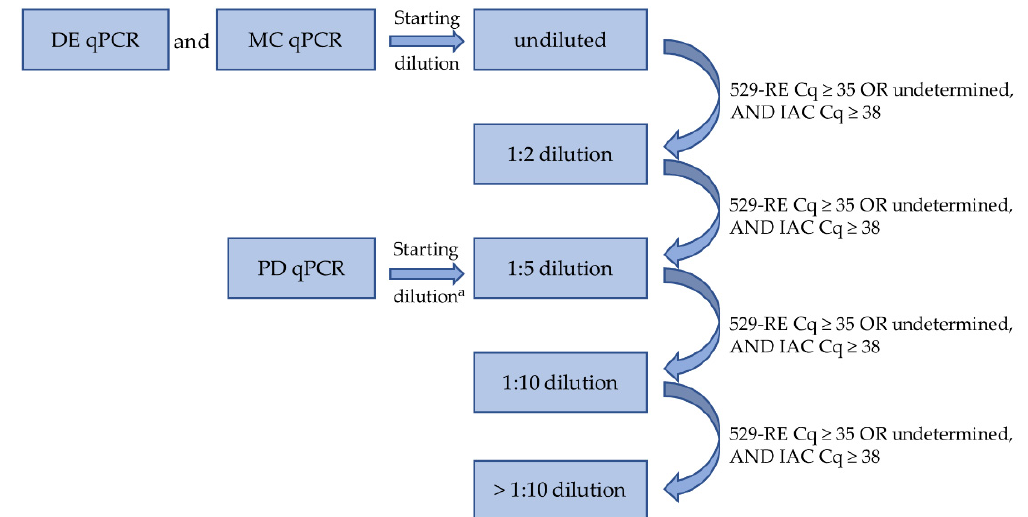
Figure 1. Methodology scheme for molecular detection of Toxoplasma gondii , showing different dilution levels used in qPCR. We used 10 µ L of template DNA for the detection of T. gondii DNA via 529-bp repetitive element (RE) qPCR. DNA from direct DNA extraction (DE) from 5 g of muscle tissue was analysed via 529-RE qPCR (DE qPCR). DNA of 50 g of muscle tissue was examined by 529-RE qPCR after magnetic capture (MC qPCR). Another 50 g of muscle tissue was investigated via 529-RE qPCR after pepsin digestion (PD) and DNA extraction (PD qPCR). a Based on previous evaluation experiments, 1:5 dilution was selected as the first dilution level for PD qPCR.